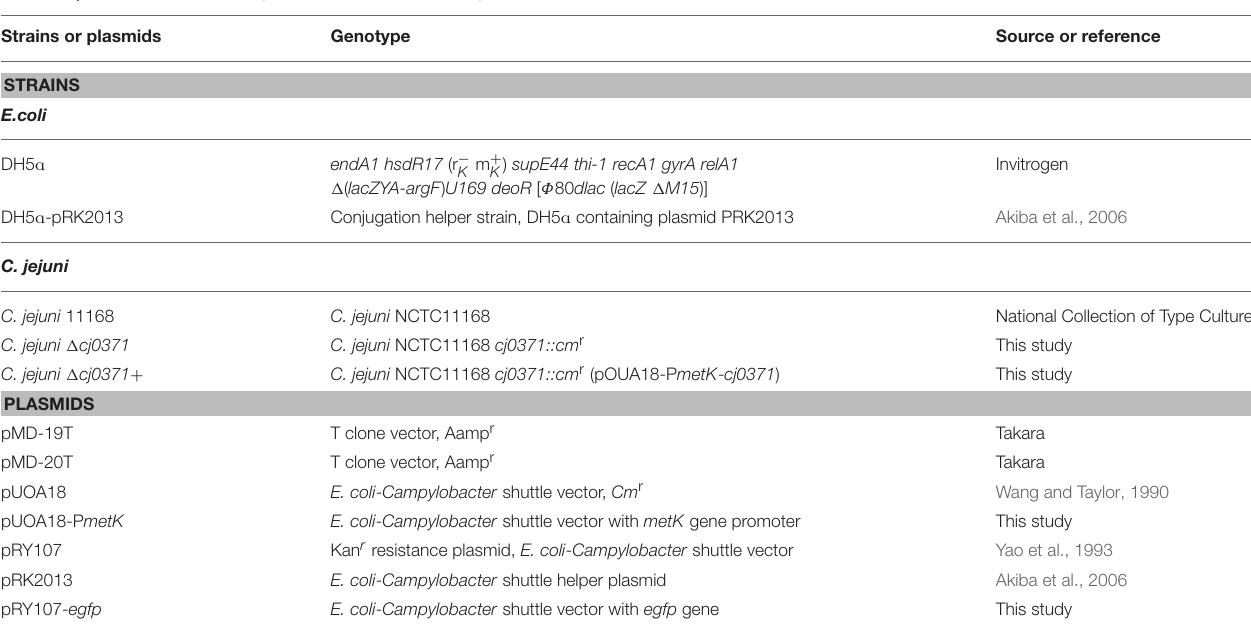
TABLE 1 | Bacterial strains and plasmids used in this study. Strains or plasmids Genotype Source or